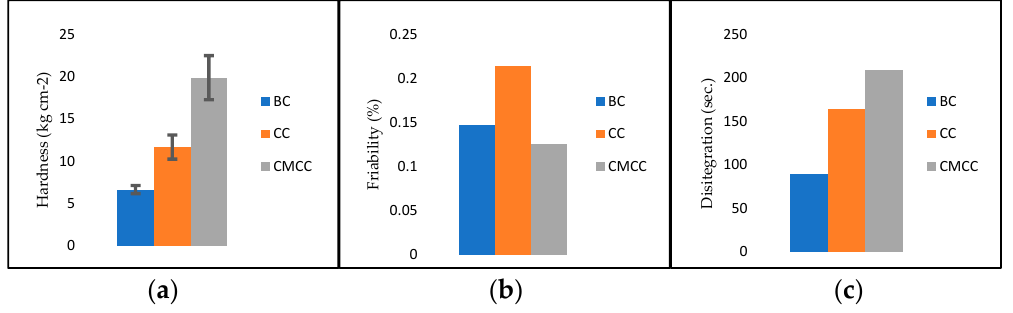
Figure 4. Results of quality control tests for the tablets. ( a ) Hardness for tablets with BC, CC, and CMCC with standard deviation. ( b ) Friability or percentage of weight loss of acetaminophen tablets